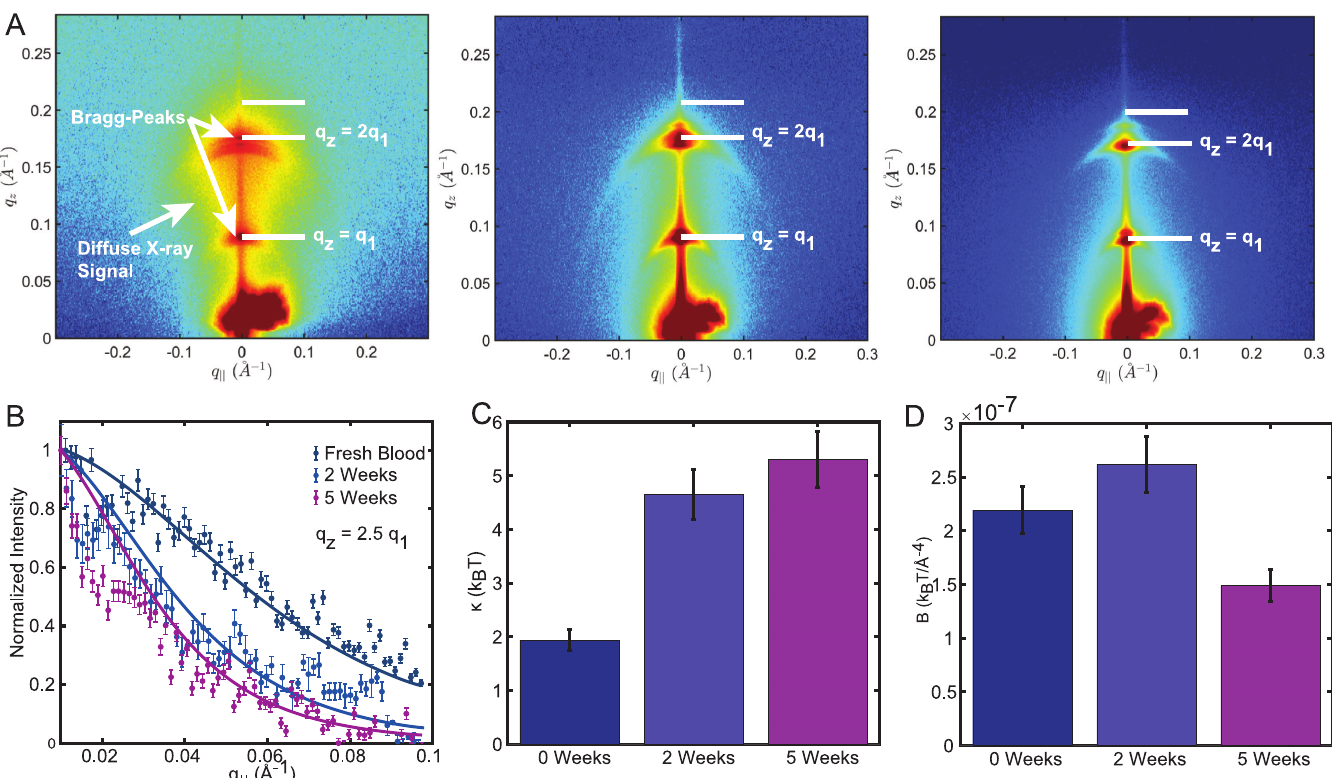
Fig 3. A Two-dimensional X-ray intensity maps measured at 99.9% RH. A diffuse cloud of X-ray signal was observed as the result of out-of-plane fluctuations. Line-cuts at q z = 2.5 � q 1 are depicted in B . The bending modulus κ and membrane interaction modulus B were determined by fitting S ( q ) to the data, and are visualized as bar graph in C and D